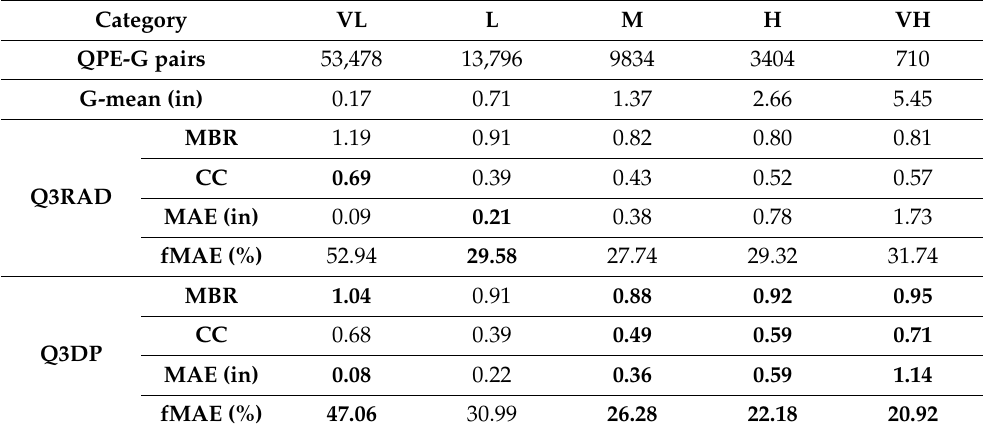
Table 2. Mean bias ratio (MBR), correlation coefficient (CC), mean absolute error (MAE) and fractional MAE of the Q3RAD and Q3DP 24 h QPEs for predefined 24 h rainfall categories. The bold numbers indicate the better scores among the two